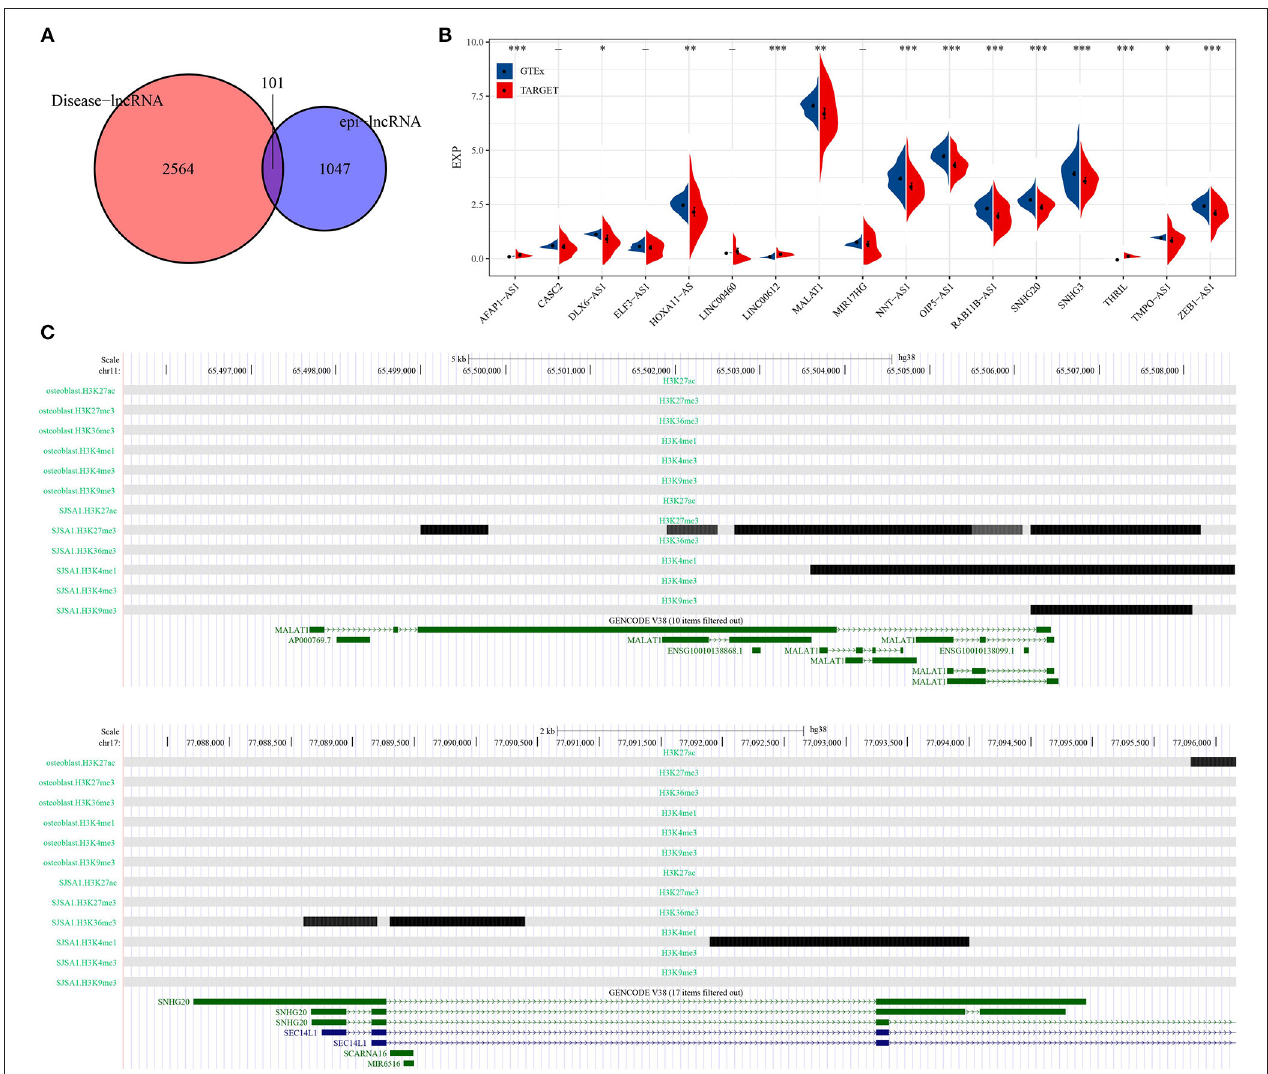
FIGURE 3 | Identification of epi-lncRNAs specifically expressed in osteosarcoma. (A) The venn diagram of the intersection of cancer-related lncRNAs and osteosarcoma epi-lncRNAs in Lnc2Cancer. (B) Analysis of the expression of 17 osteosarcoma emblematical epi-lncRNAs in normal samples and osteosarcoma samples. (C) Histone modification profiles of MALAT and SNHG20. * P < 0.05, ** P < 0.01, *** P <